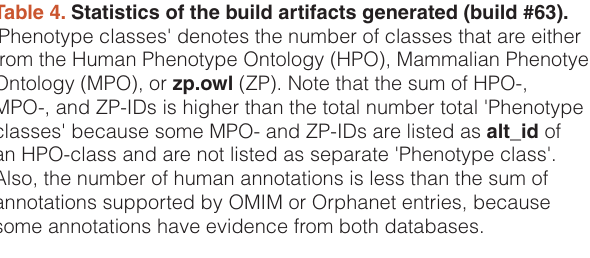
Table 4. Statistics of the build artifacts generated (build #63). 'Phenotype classes' denotes the number of classes that are either from the Human Phenotype Ontology (HPO), Mammalian Phenotye Ontology (MPO), or zp.owl (ZP). Note that the sum of